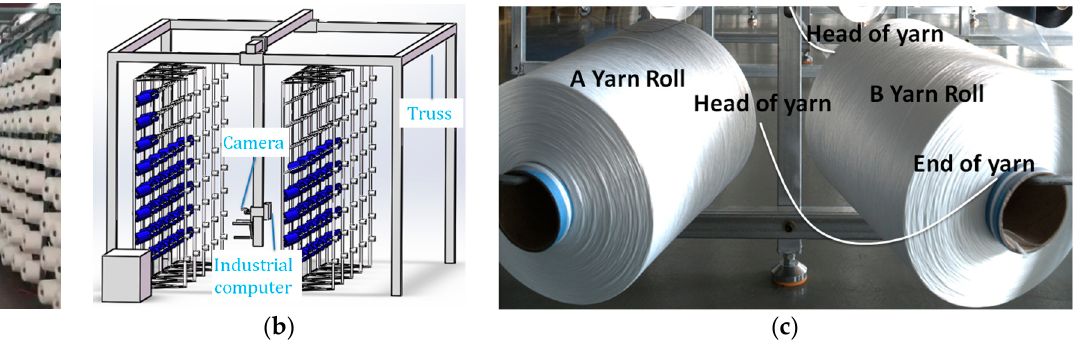
Figure 1. Environment. ( a ) Production environment. ( b ) Truss and vision system. ( c ) Yarn’s head and end is connected.